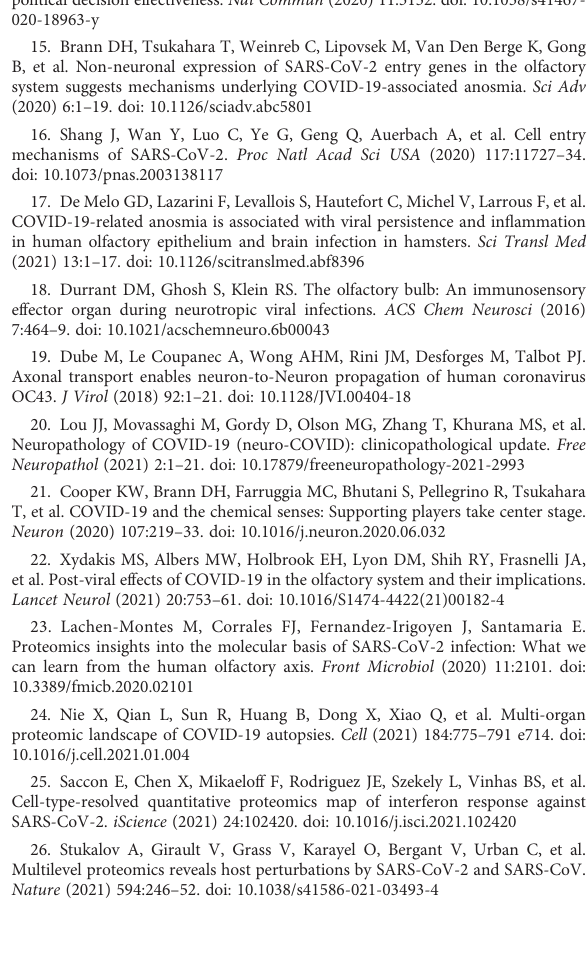
Immunological functionality derived from the interlocking of transcriptome and proteome